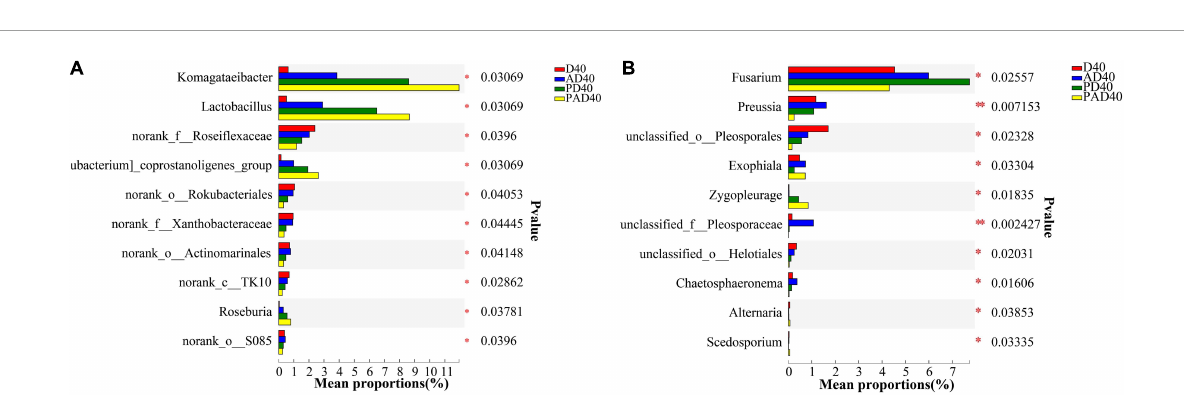
thus making them the dominant bacteria ( Figure 4D ). Pichia (22.8%), Dekkera (16.61%), and Gibberella (15.60%) were the dominant genera after ABA-PAM (PAD40)